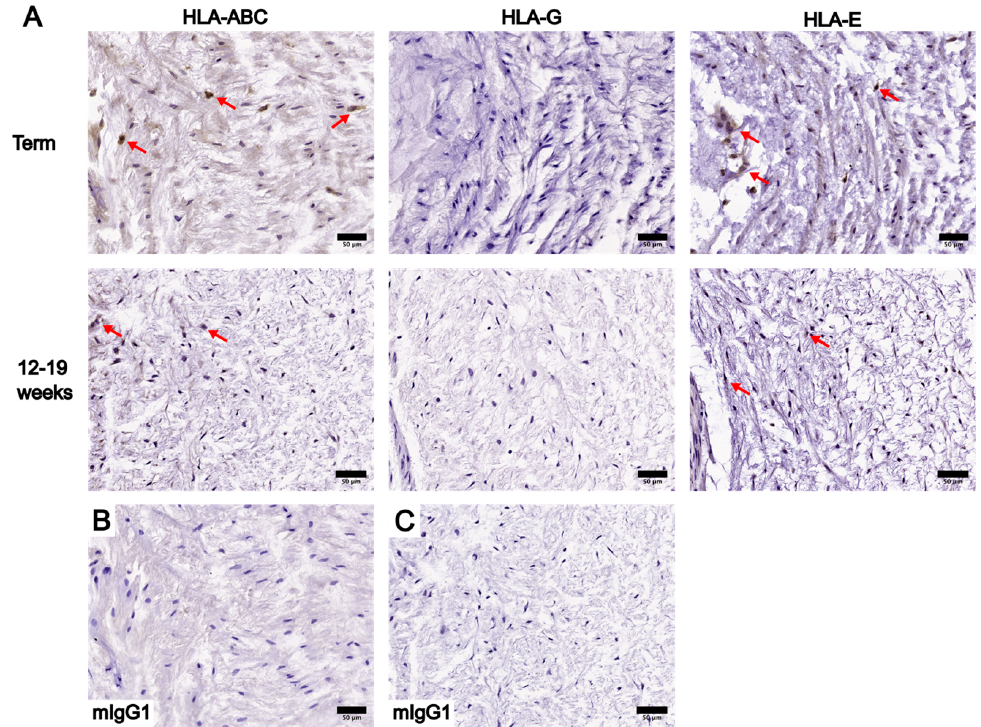
Figure 5. Comparison of IHC staining results of HLA-ABC, HLA-G, and HLA-E in whole UC cross- sections at term and between 12 and 19 weeks, focusing on the PVWJ. ( A ) IHC staining results of term UC are shown in the first row, and IHC staining results of UC between 12 and 19 weeks are shown in the second row. Red arrows: examples of cells in the PVWJ showing positive staining for the corresponding HLA of interest. ( B ) Negative control of term UC IHC staining results using an anti-mIgG1 antibody. ( C ) Negative control of 12–19-week UC IHC staining results using an anti-mIgG1 antibody. Scale bars = 50 µ